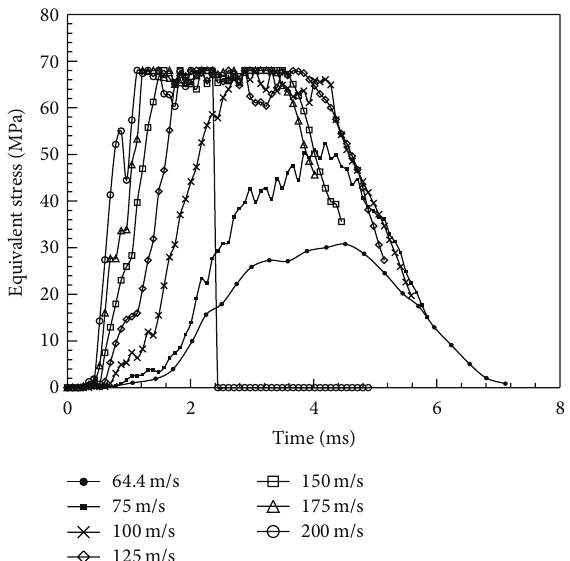
Figure 14: Equivalent stress history at Location 2.